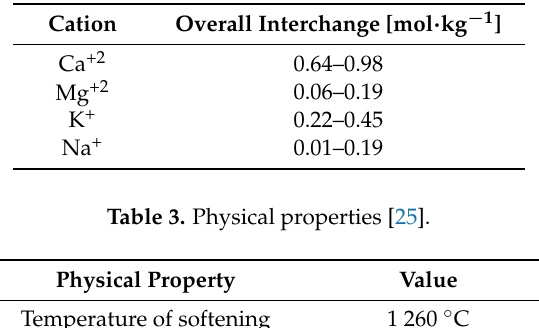
Table 2. Ion exchange properties [25].